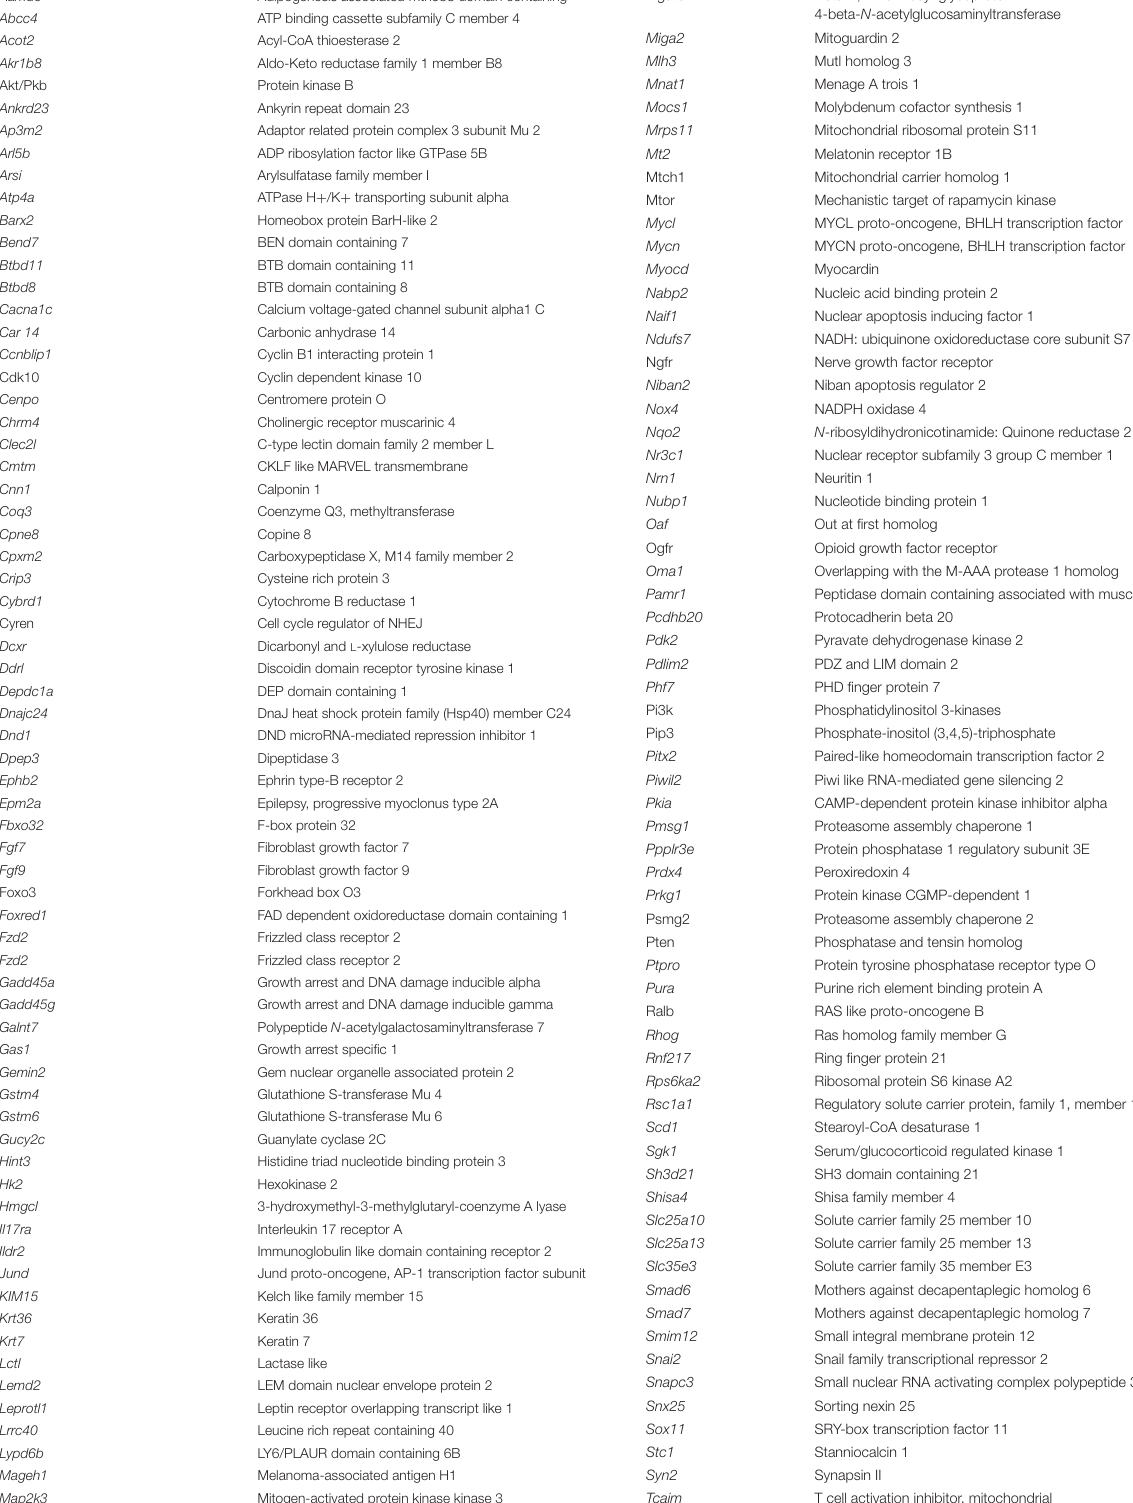
TABLE 1 | List of gene names and gene